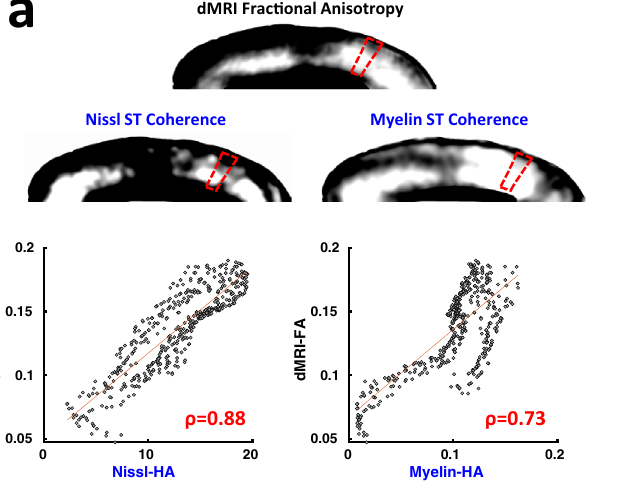
parameter maps and MRI at 75 μ m resolution. The red trapezoids indicate a columnar parcel example. The bottom row shows representative pixelwise scatter plots of the co-registered data within the sample parcel of cortex, and Pearson correlation ( ρ ) coef fi cients between histological variables and MRI variables. ST structure tensor. Source data are provided as a source sata fi le.